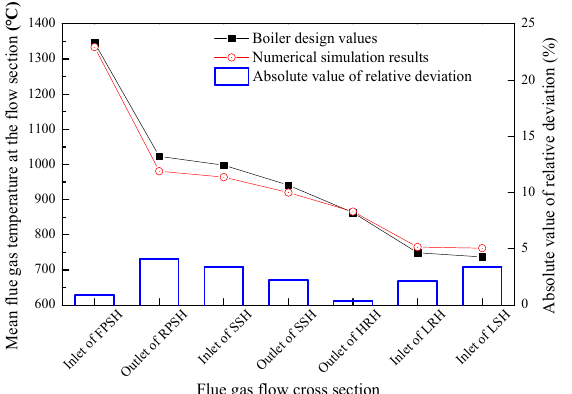
Figure 5. Numerical simulation results and design values of flue gas temperatures in different cross sections.